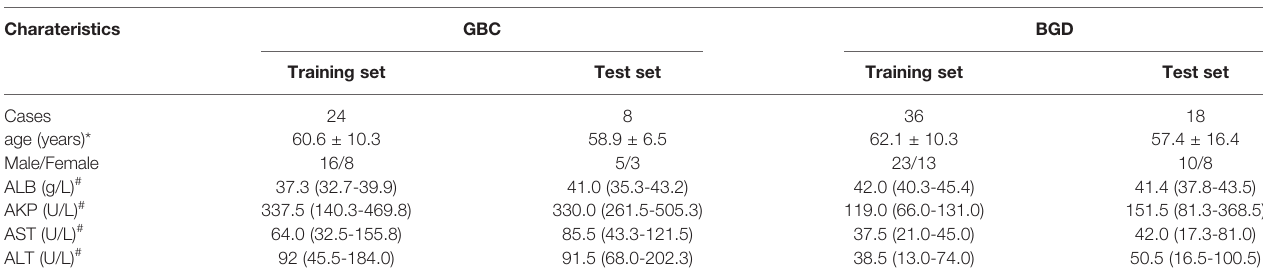
TABLE 1 | Clinical characteristics of GBC and BGD patients. Charateristics